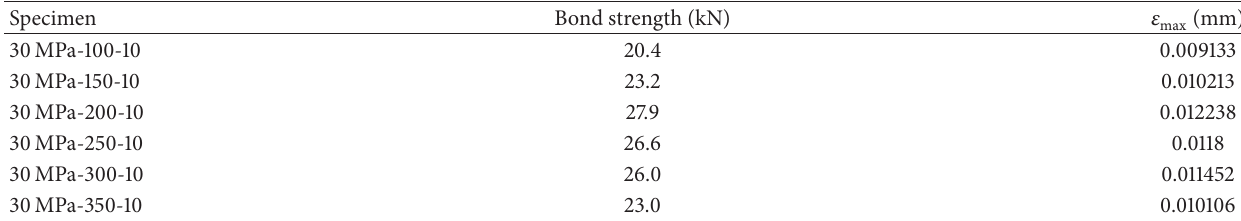
Table 4: Calculation for each specimen test by Abaqus